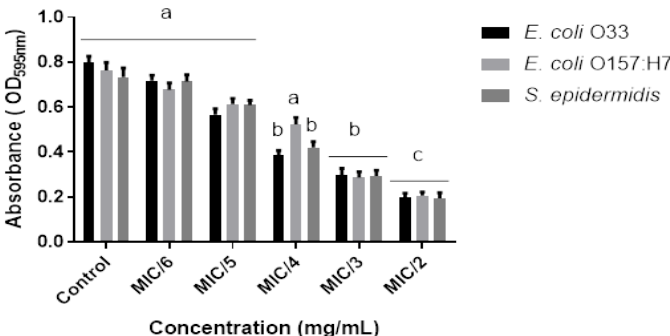
Figure 2. Biofilm inhibition activity of thymol-carvacrol-chemotype (II) oil from Lippia origanoides (at di ff erent sub-lethal MIC 50 concentrations) against E. coli O33 (black bars), E. coli O157:H7 (light-gray bars), and S. epidermidis (dark-gray bars). Data are presented as mean ± SD of absorbance (at 595 nm). ANOVA ( p < 0.05) was performed, followed by Tukey’s Test. Different letters indicate significant differences between the test groups.